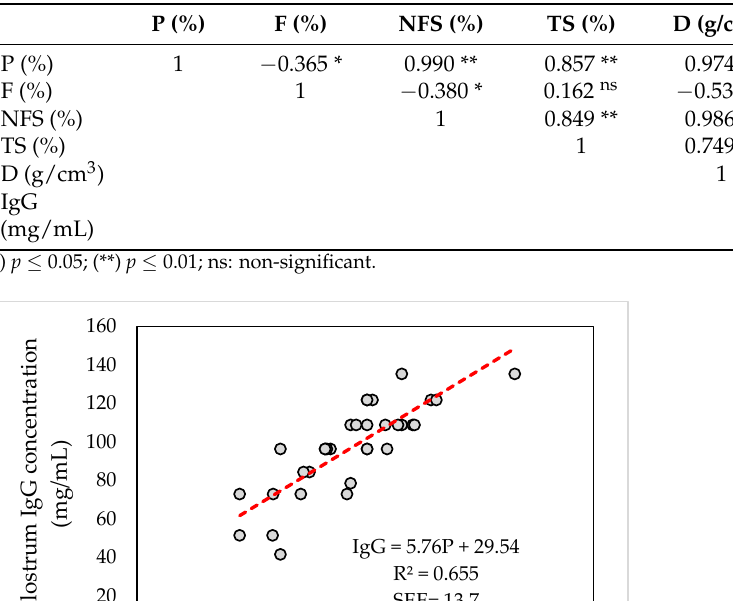
Table 6. Pearson’s correlation matrix for the components of ewe’s colostrum.